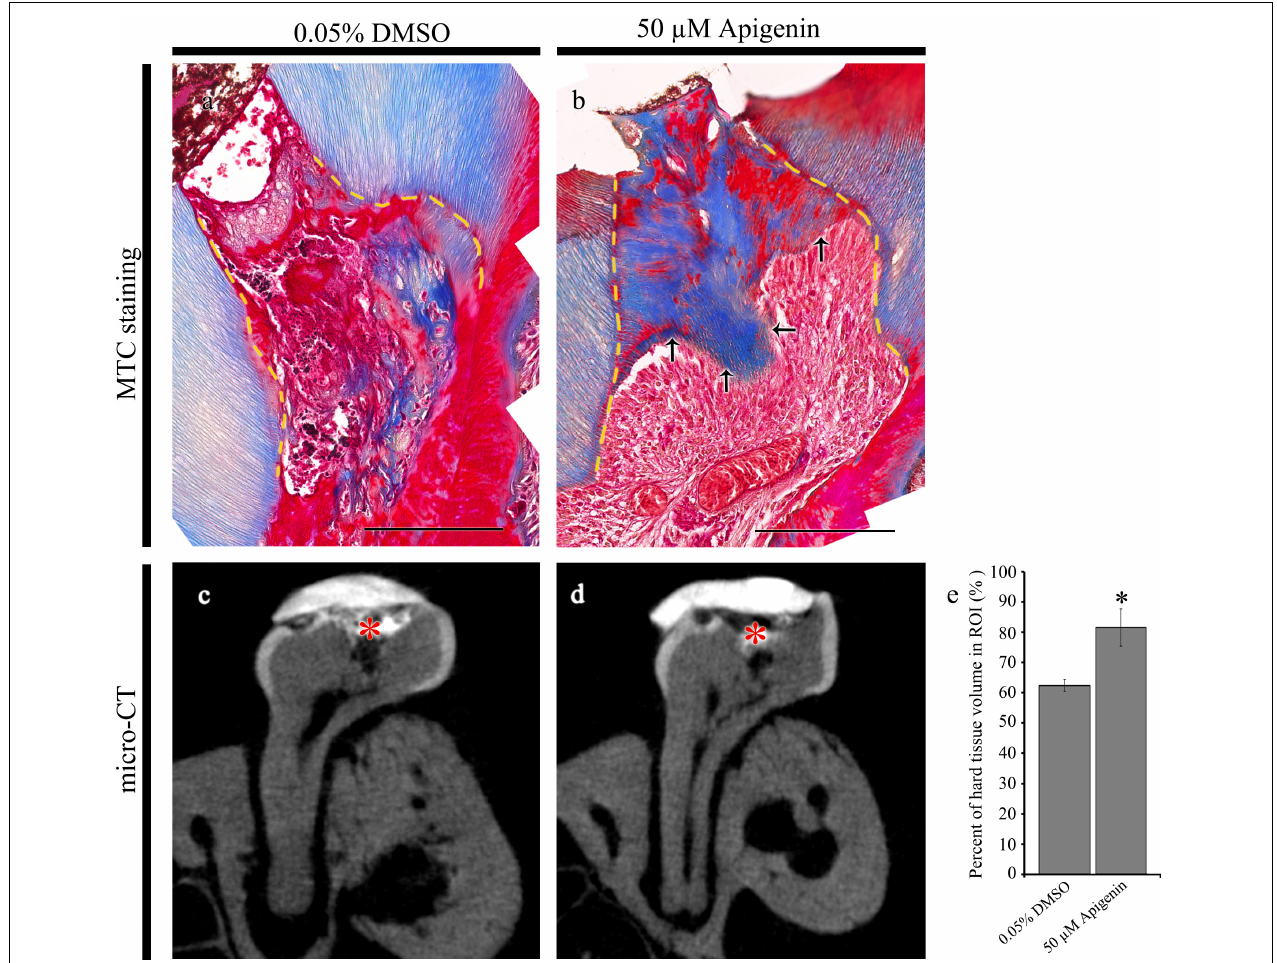
FIGURE 4 | Micro-CT examinations and Masson’s trichrome (MTC) staining after 42 days from cavity preparation. MTC staining showing dentin-bridge (arrows) formation in the apigenin-treated specimen (a,b) . Micro-CT showing pulpal access preparation and dentin-bridge formation after 42 days of cavity preparation (c,d) . The percentage of hard tissue regenerated within the region of interest after 42 days of cavity preparation ( N = 3) (e) . ROI, region of interest. Red ∗ indicates the region of cavity preparation (c,d) . The yellow dotted line indicates the existing dentin in the cavity (a,b) . ∗ indicates p < 0.05 (e) . Scale bars: 50 µ m (a,b)